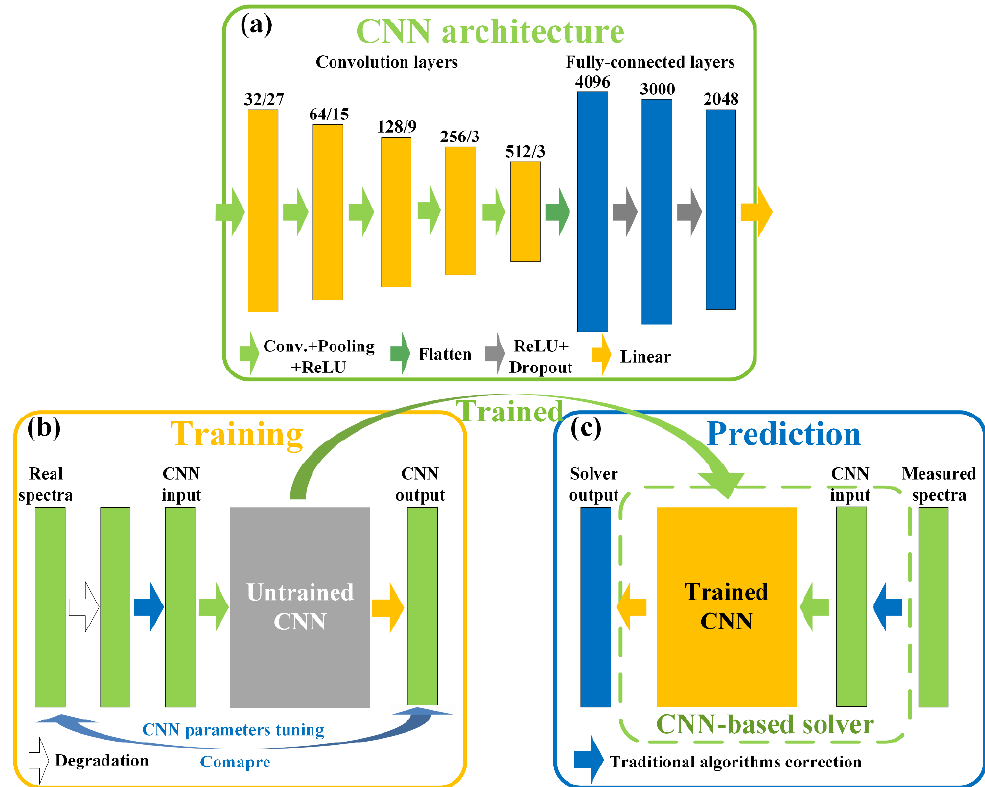
Figure 1. Schematic of the proposed method. ( a ) CNN architecture. ( b ) CNN training stage. ( c ) Trained CNN predicting process.